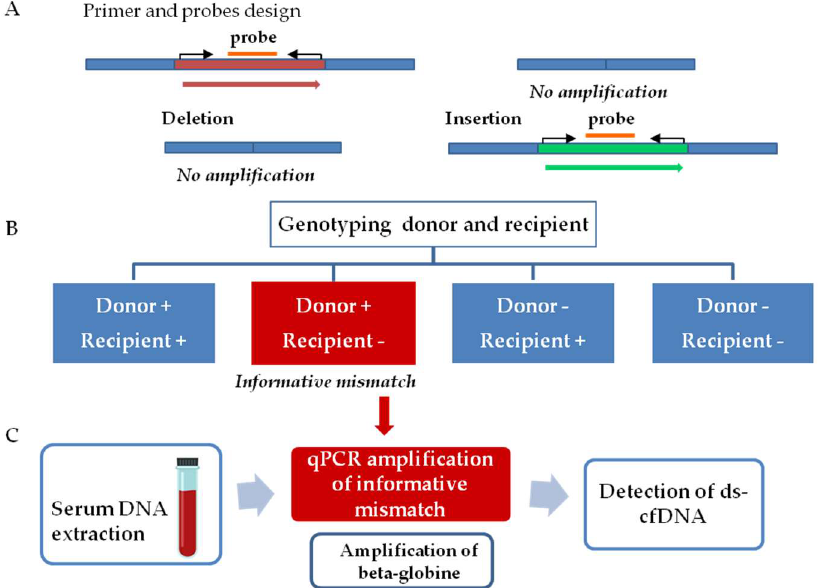
Figure 1. Workflow for detection of ds-cfDNA. ( A ) Primers and probes were designed for ampli- fication of small fragments (<150 pb) on the insertion/deletion sequence. The workflow involves two steps. ( B ) Genotyping donor and recipient samples. A mismatch was considered informative when a deleted sequence on the host DNA but not in the donor DNA. ( C ) cfDNA extraction